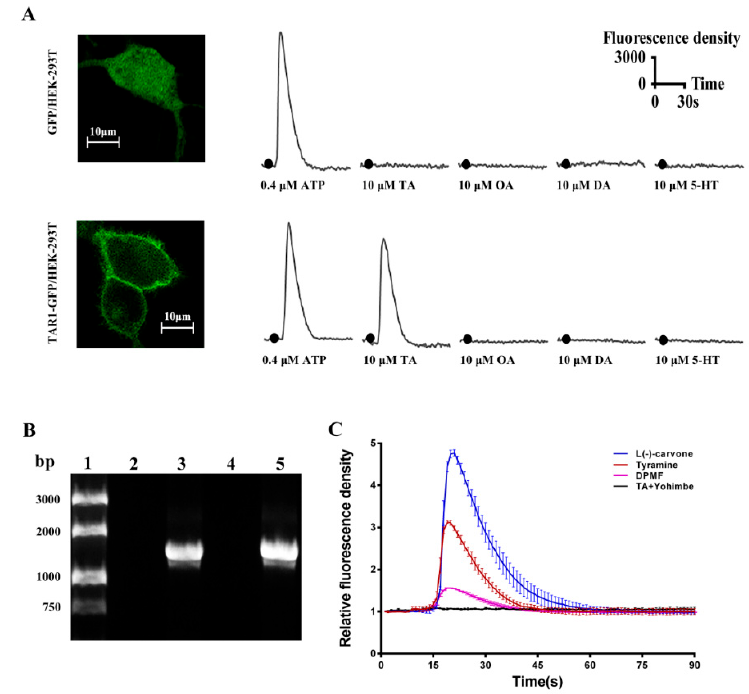
Figure 4. Effects of different reagents (biogenic amines and putative agonists) on (Ca 2+ )i in PxTAR1 over-expressing cells. ( A ) Effects of biogenic amines on intracellular calcium concentration in HEK-293T cells. ( B ) RT-PCR amplification of tar1 gene using total RNA extracted from GFP/293T and TAR1/293T cells. Lane 1, DNA marker; lane 2, HEK-293 cells stable expression of GFP protein (negative control); lane 3, HEK-293 cells’ stable expression of PxTAR1 protein; lane 4, total RNA from TAR1/293T cells as template; lane 5, positive control (pEGFP-N1-PxTAR1 plasmid). Expected amplification fragment was 1404 base pairs. ( C ) Effects of different agonists on (Ca 2+ )i in TAR1/293T cells. Data are presented as the mean of at least three independent experiments. Relative fluorescence density was defined as: real-time fluorescence density/background fluorescence density.